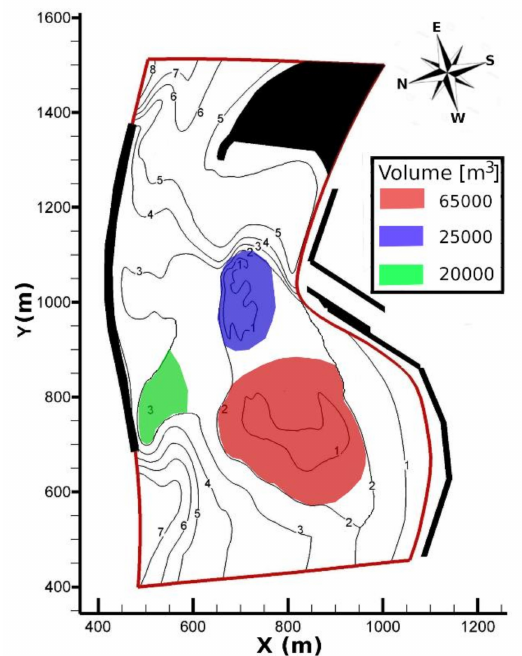
Figure 12. Configuration 1. Accretion areas after three simulated